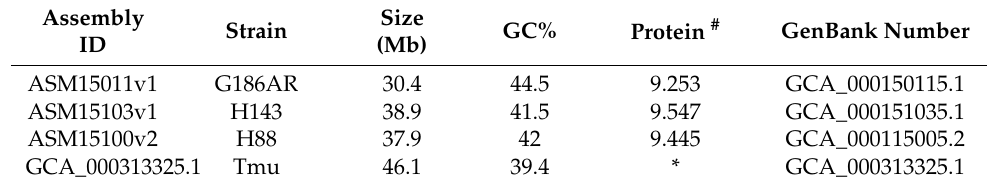
Table 1. General information about the four Histoplasma capsulatum strains used in this work. Assembly Size Strain GC% Protein # GenBank Number ID (Mb) ASM15011v1